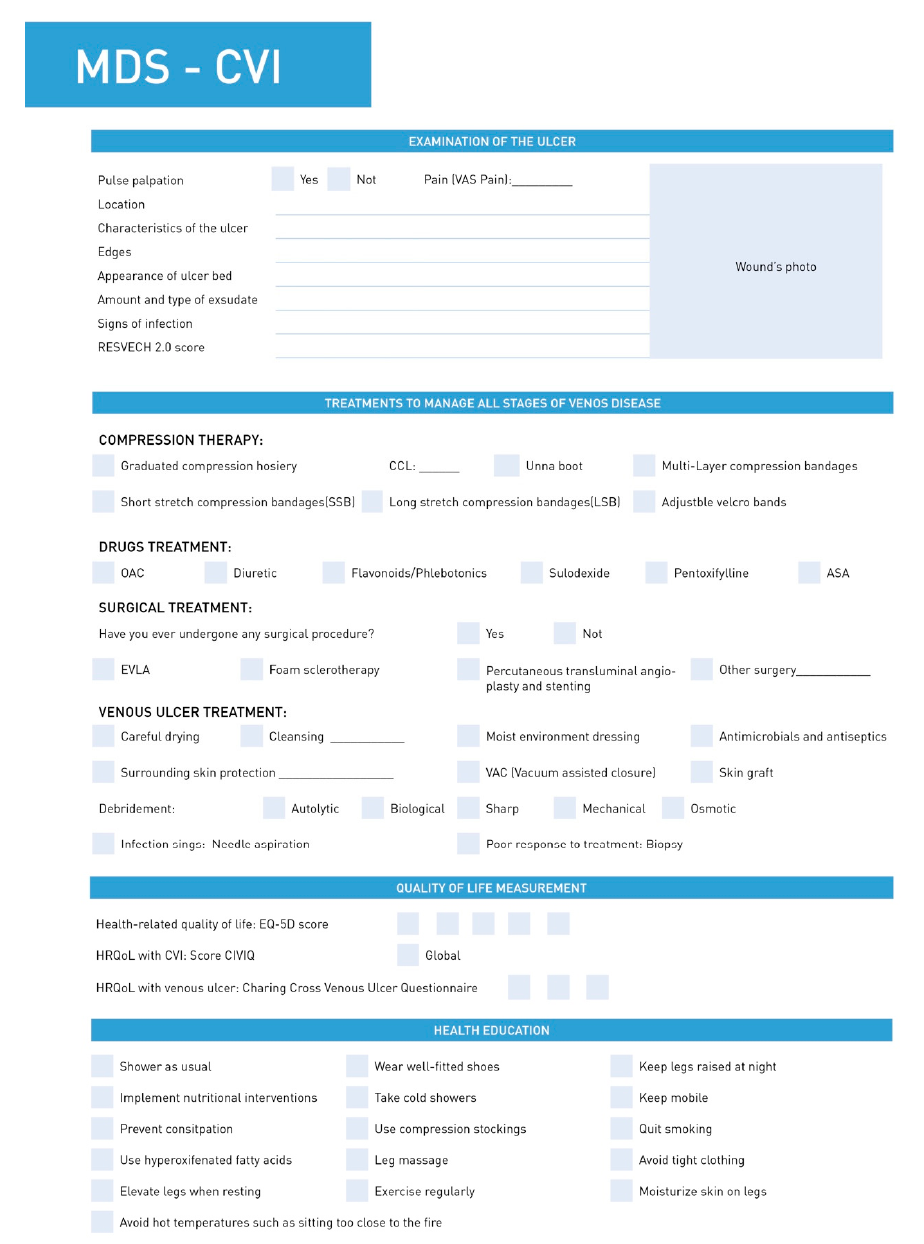
Figure 3. Second page of the MSD-CVI.